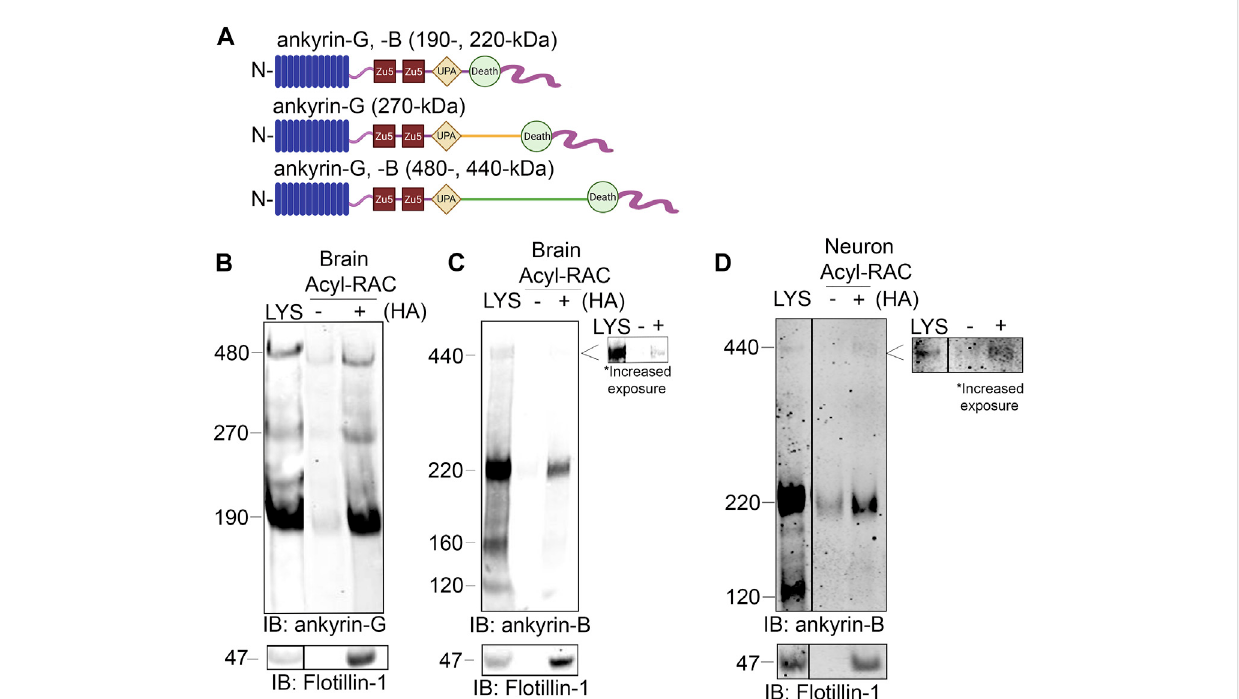
FIGURE 1 Ankyrin-B is S -palmitoylatedinwholemousebrainandinculturedneurons. (A) .Schematicofneuronalankyrin-Gandankyrin-B,whichsharehighly homologousdomains:theN-terminalankyrinrepeatdomain(blue),twoZU5spectrinbindingdomains(red),aUPAdomain(yellow),adeathdomain(light green), and a highly divergent unstructured C-terminal regulatory domain (pink). The giant isoforms (480-kDa ankyrin-G and 440-kDa ankyrin-B)have a large single exon (orange and dark green) inserted between their respective UPA and death domains. (B) . Whole brains from C57Bl/6J mice were processed for the Acyl-RAC assay to detect S -palmitoylation. S -palmitoylation of all neuronal isoforms of ankyrin-G (190-, 270-, and 480-kDa) is detectedinwholebrainfromC57Bl/6Jmiceusingan antibodyagainst endogenous ankyrin-G, asdemonstratedbytheanti-ankyrin-Gsignal inthe ‘ +HA ’ lane, comparedto the minimal background signal in thenegative control ‘ -HA ’ lane. Flotillin-1 is used as apositive control for the Acyl-RAC assay (N= 3). (C) . S -palmitoylationoftheknownneuronalisoformsofankyrin-B(220-and440-kDa)isdetectedbyAcyl-RACinwholebrainfromC57Bl/6Jmiceusing an antibody against endogenousankyrin-B (N= 3). (D) . DIV17 cultured hippocampal neurons from C57Bl/6J miceweresubjectedto theAcyl-RAC assay. S